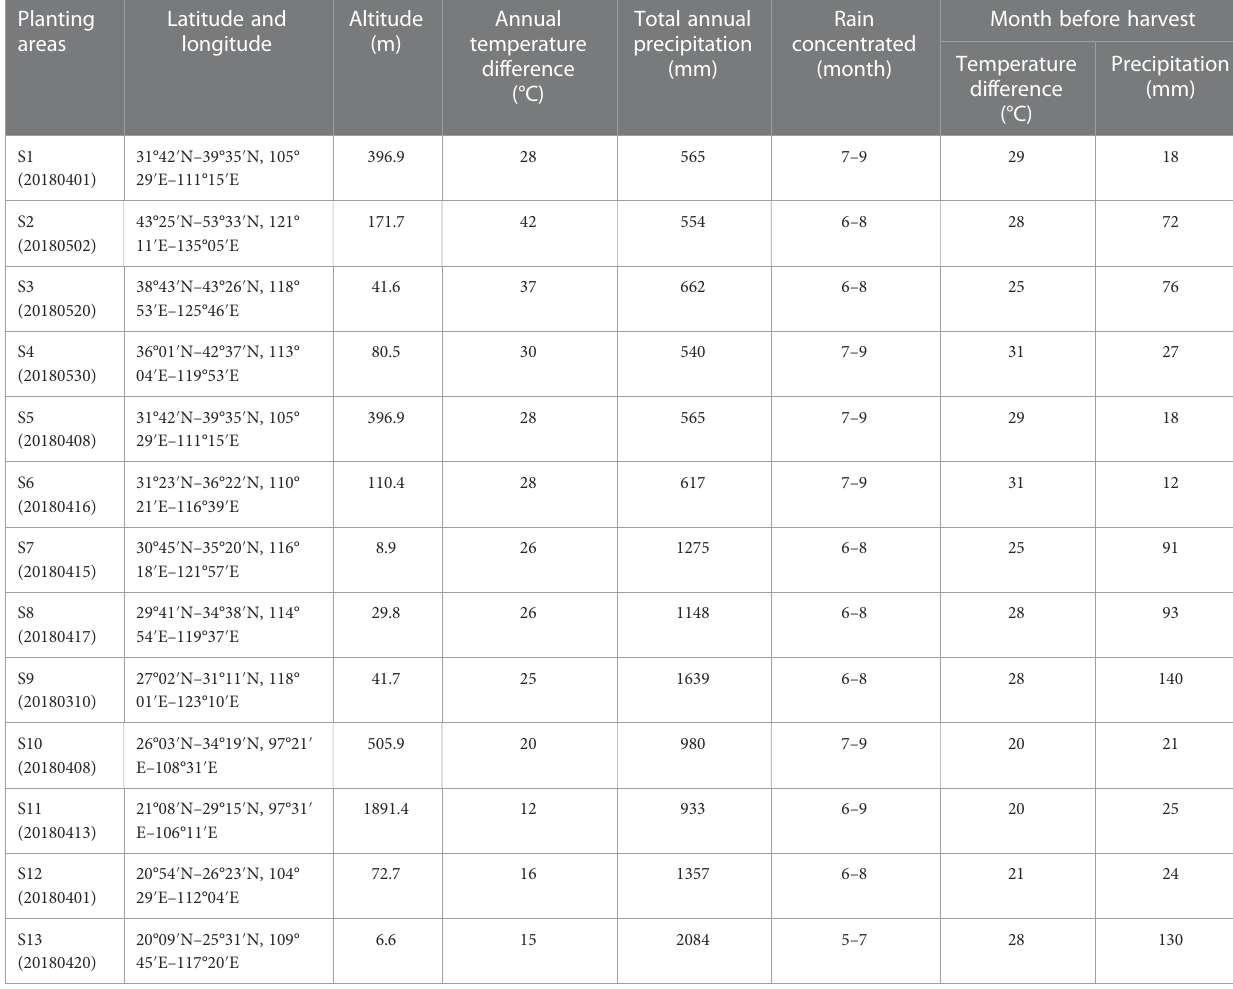
TABLE 1 Planting conditions of mulberry from different planting areas. Planting